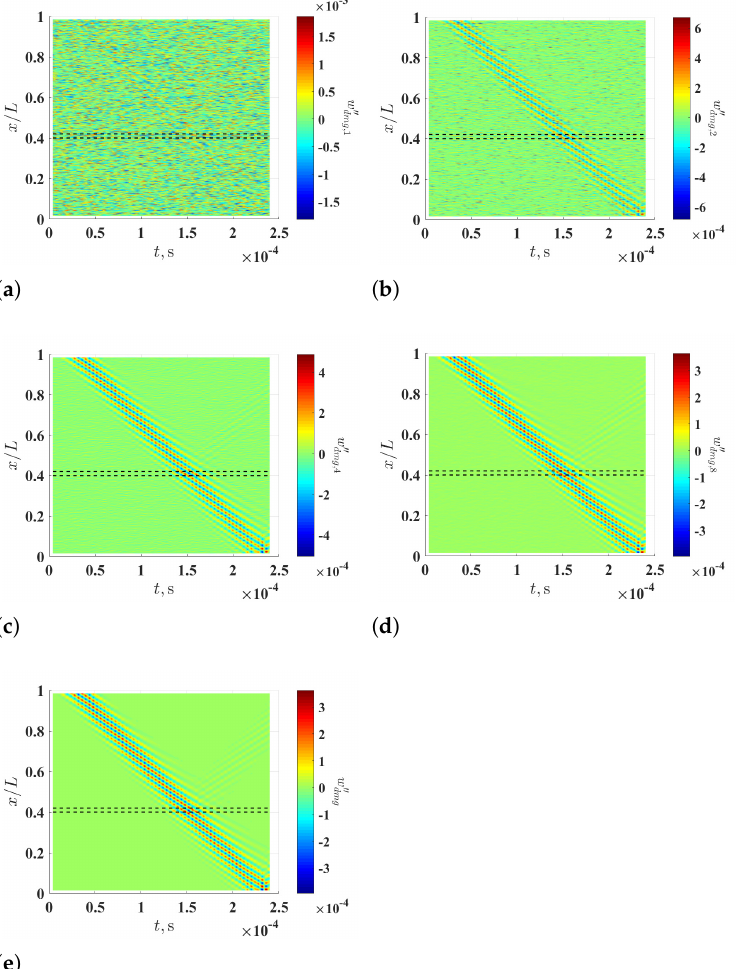
Figure 3. Curvature waveforms of the noise-contaminated wave of the damaged beam, which are calculated using the multi-resolution finite difference scheme with ( a ) r = 1, ( b ) r = 2, ( c ) r = 4 and ( d ) r = 8, and ( e ) curvature waveforms of the noise-free wave of the damaged, which are calculated using the multi-resolution finite difference scheme with r = 8. Locality and extent of the damage are indicated by two dashed